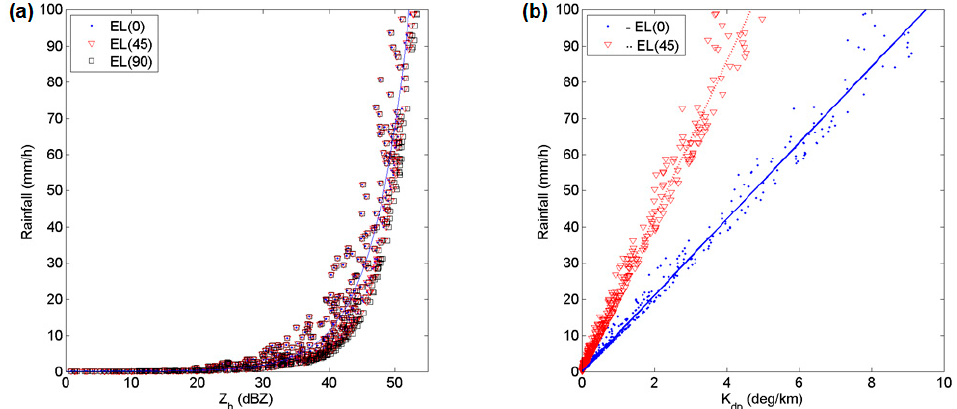
Figure 7. Scatter plots of ( a ) Z h versus rainfall, and ( b ) K dp versus rainfall according to elevation.